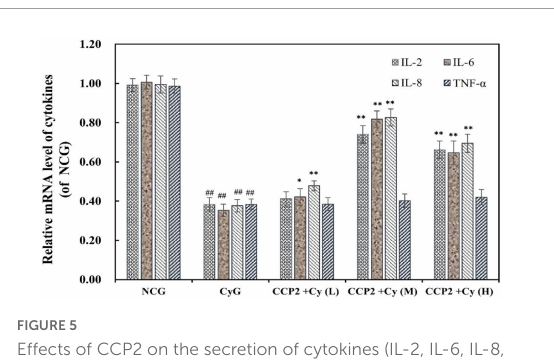
FIGURE4 Effects of CCP2 on the spleen tissues showed in HE-stained histopathological images (scale bar = 100 µ m, objective: 20 × ). NCG, normal control group; CyG, cyclophosphamide treatment group; CCP2 + Cy(L), Cy + CCP2 treatment group (100 mg kg − 1 day − 1 ); CCP2 + Cy(M): Cy + CCP2 treatment group (200 mg kg − 1 day − 1 ), CCP2 + Cy(H): Cy + CCP2 treatment group (400 mg kg − 1 day − 1 ).